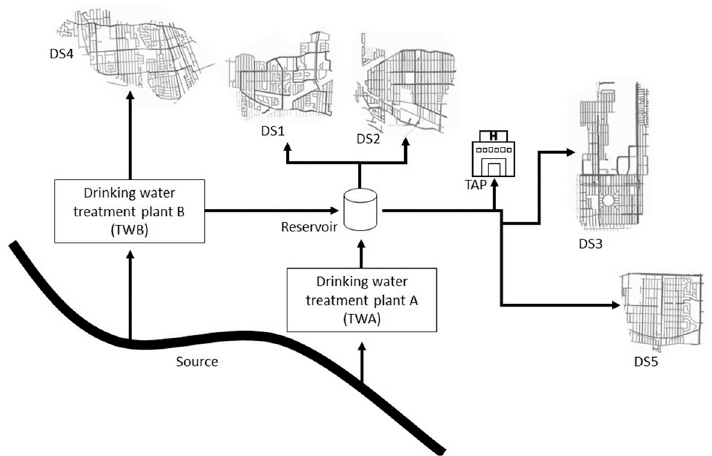
Figure 1. Schematic diagram of the drinking water distribution system sampled illustrating the subsystems: Treated water (TW), distribution system (DS), and building plumbing (TAP).